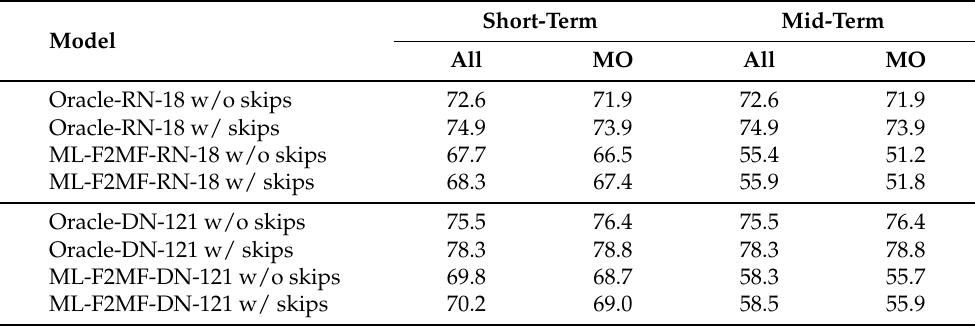
Table 5. Evaluation (mIoU) of our ML-F2MF forecasting model with single-frame segmentation models based on ResNet-18 (top section) and DenseNet-121 (bottom section) backbones. We evaluate models with and without skip-connection forecasting.